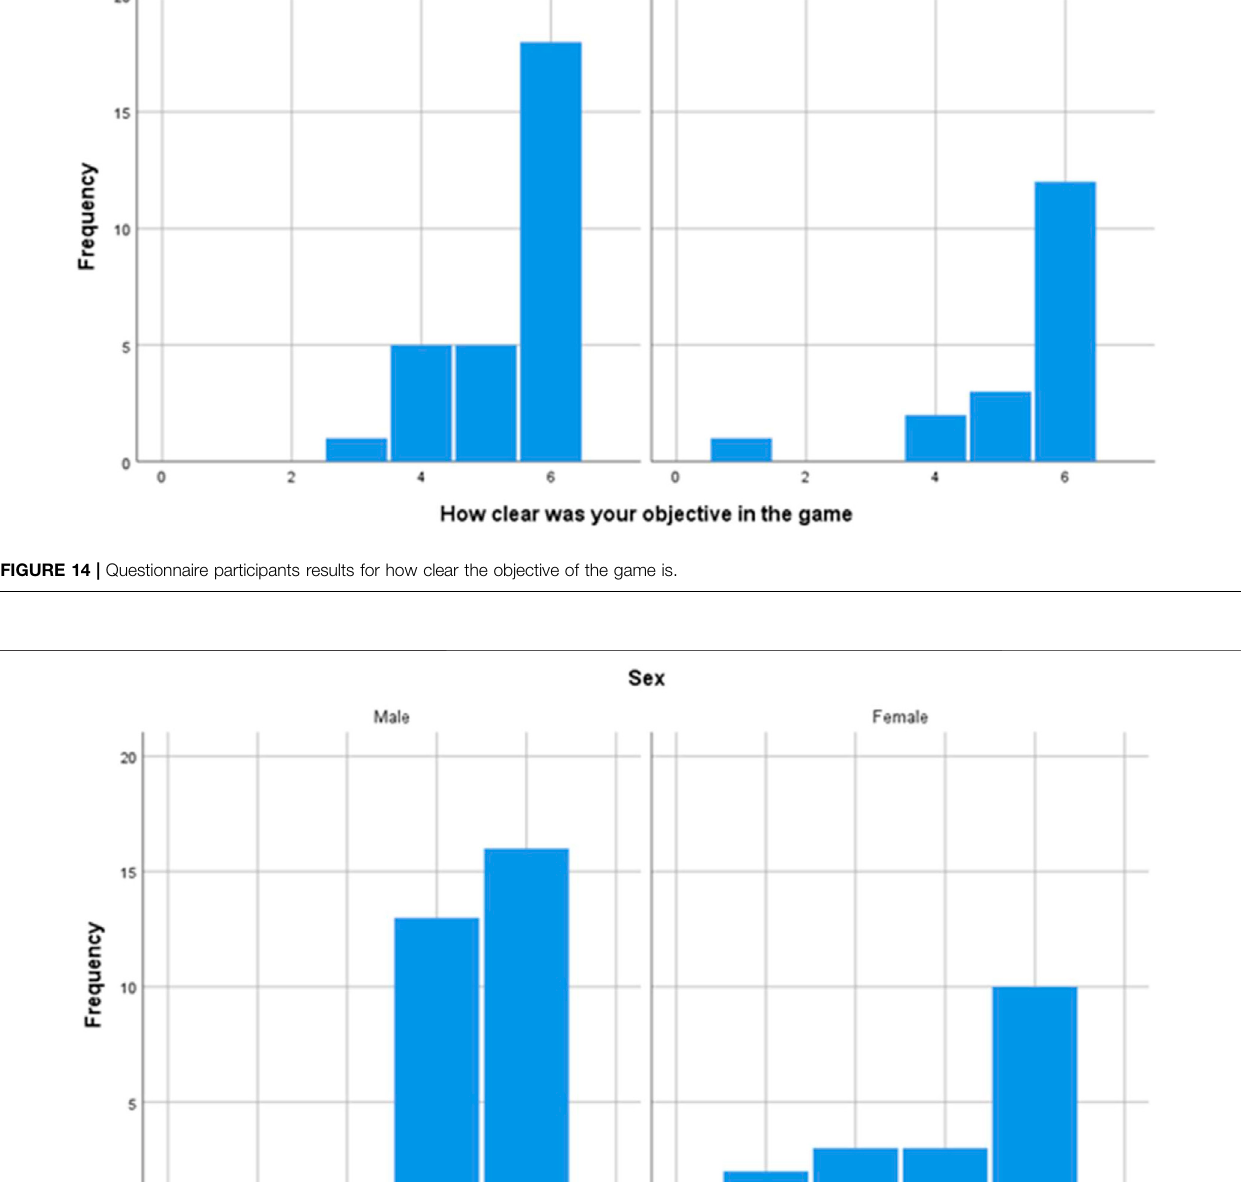
Frontiers in Built Environment |